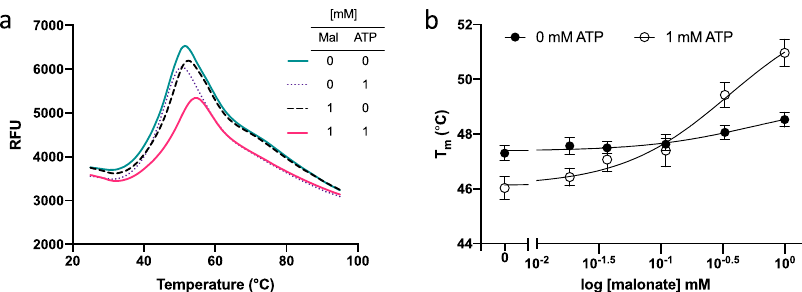
Fig. 4 Thermal denaturation analysis of SR with ATP and malonate. a Thermal denaturation curves of SR with and without 1 mM ATP and malonate. A right-shift indicates an increase in Tm and thermostability. The small right-shift and thermostability increase with the addition of malonate alone is augmented signi fi cantly when both ATP and malonate are present. b Melting temperatures of SR across a concentration series of malonate (0 – 1 mM) with and without 1 mM ATP. Tm shifts with malonate alone are negligible across the series; 1 mM ATP appears to have a destabilising effect at low concentrations of malonate before suf fi cient levels are reached to drive complex formation, resulting in a high Tm shift. The experiment was conducted in triplicate and repeated fi ve individual times. Data points represent the mean of means, and error bars show standard error of the mean (Error bars = SEM, n =